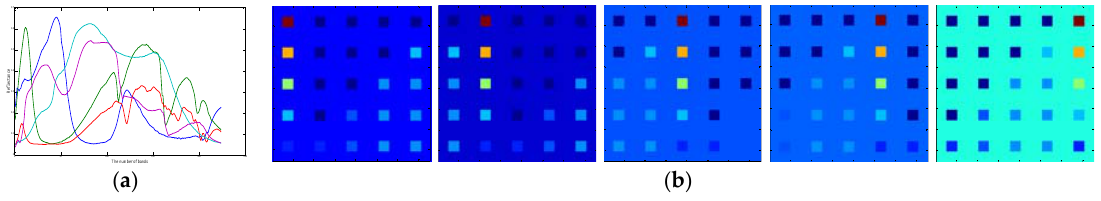
Figure 3. True fractional abundances of simulated dataset 1. ( a ) Five spectra; ( b ) True abundance images. Simulated dataset 2, with 100 × 100 pixels and 224 bands, was provided by Dr. M. D.